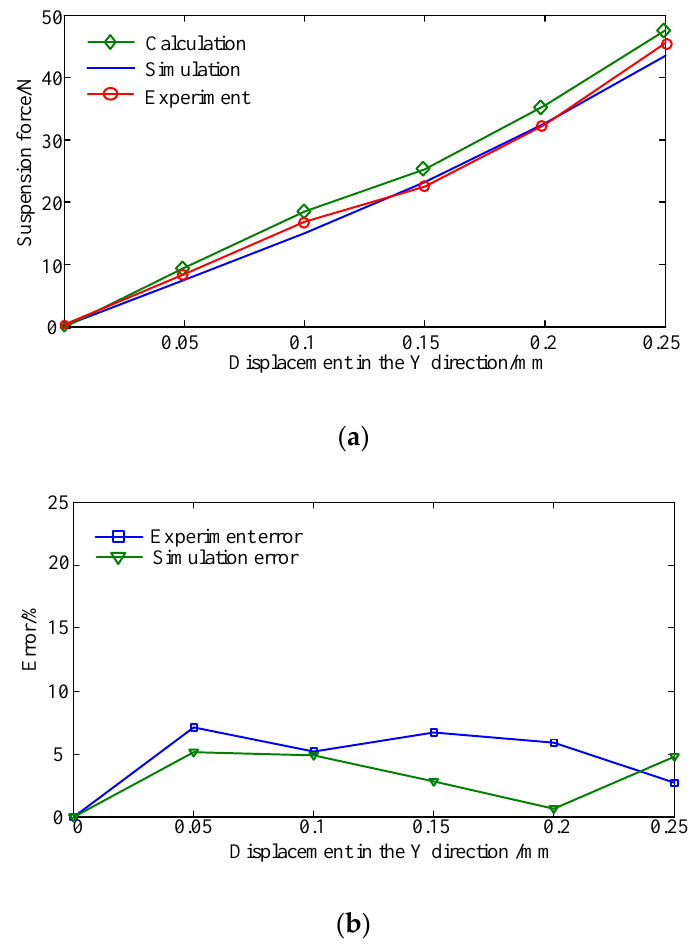
Figure 10. ( a ) Suspension force related to eccentricity along the Y-axis ( b ) Error comparison between experiment and simulation